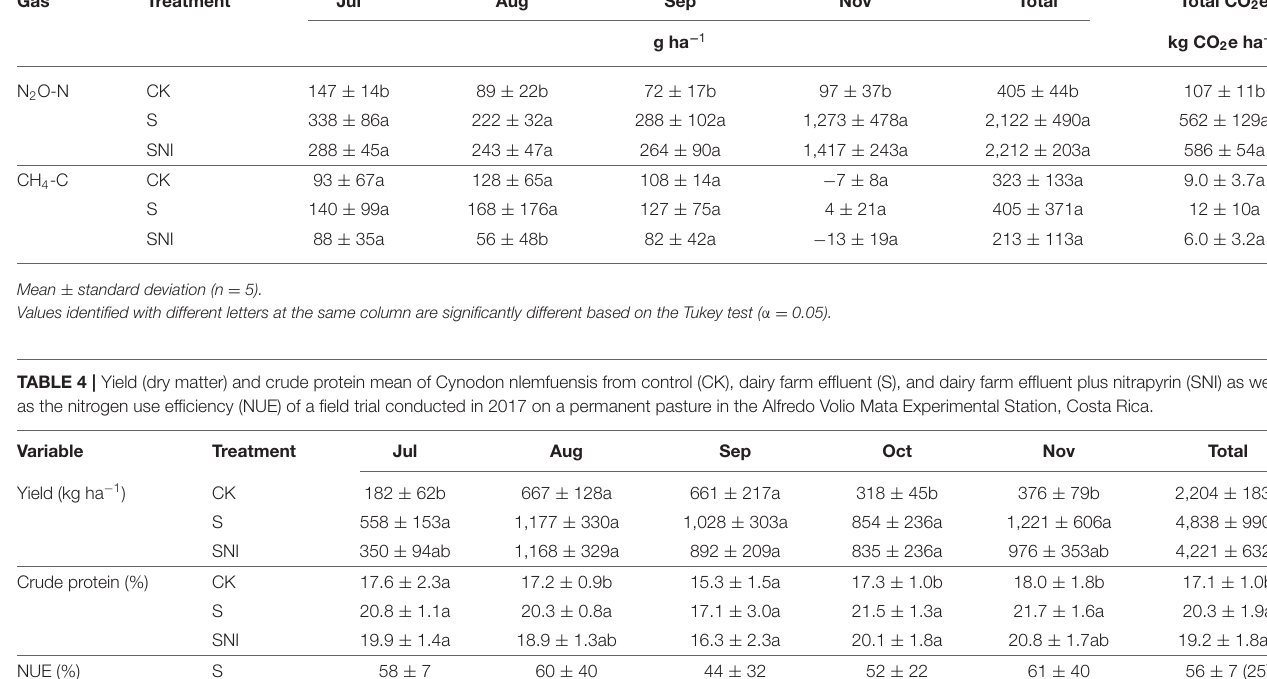
TABLE 3 | Cumulative emissions of nitrous oxide (N 2 O) and methane (CH 4 ) from control (CK), DFE (S), and DFE plus nitrapyrin (SNI) of a field trial conducted in 2017 on a permanent pasture in the Alfredo Volio Mata Experimental Station, Costa Rica. Gas